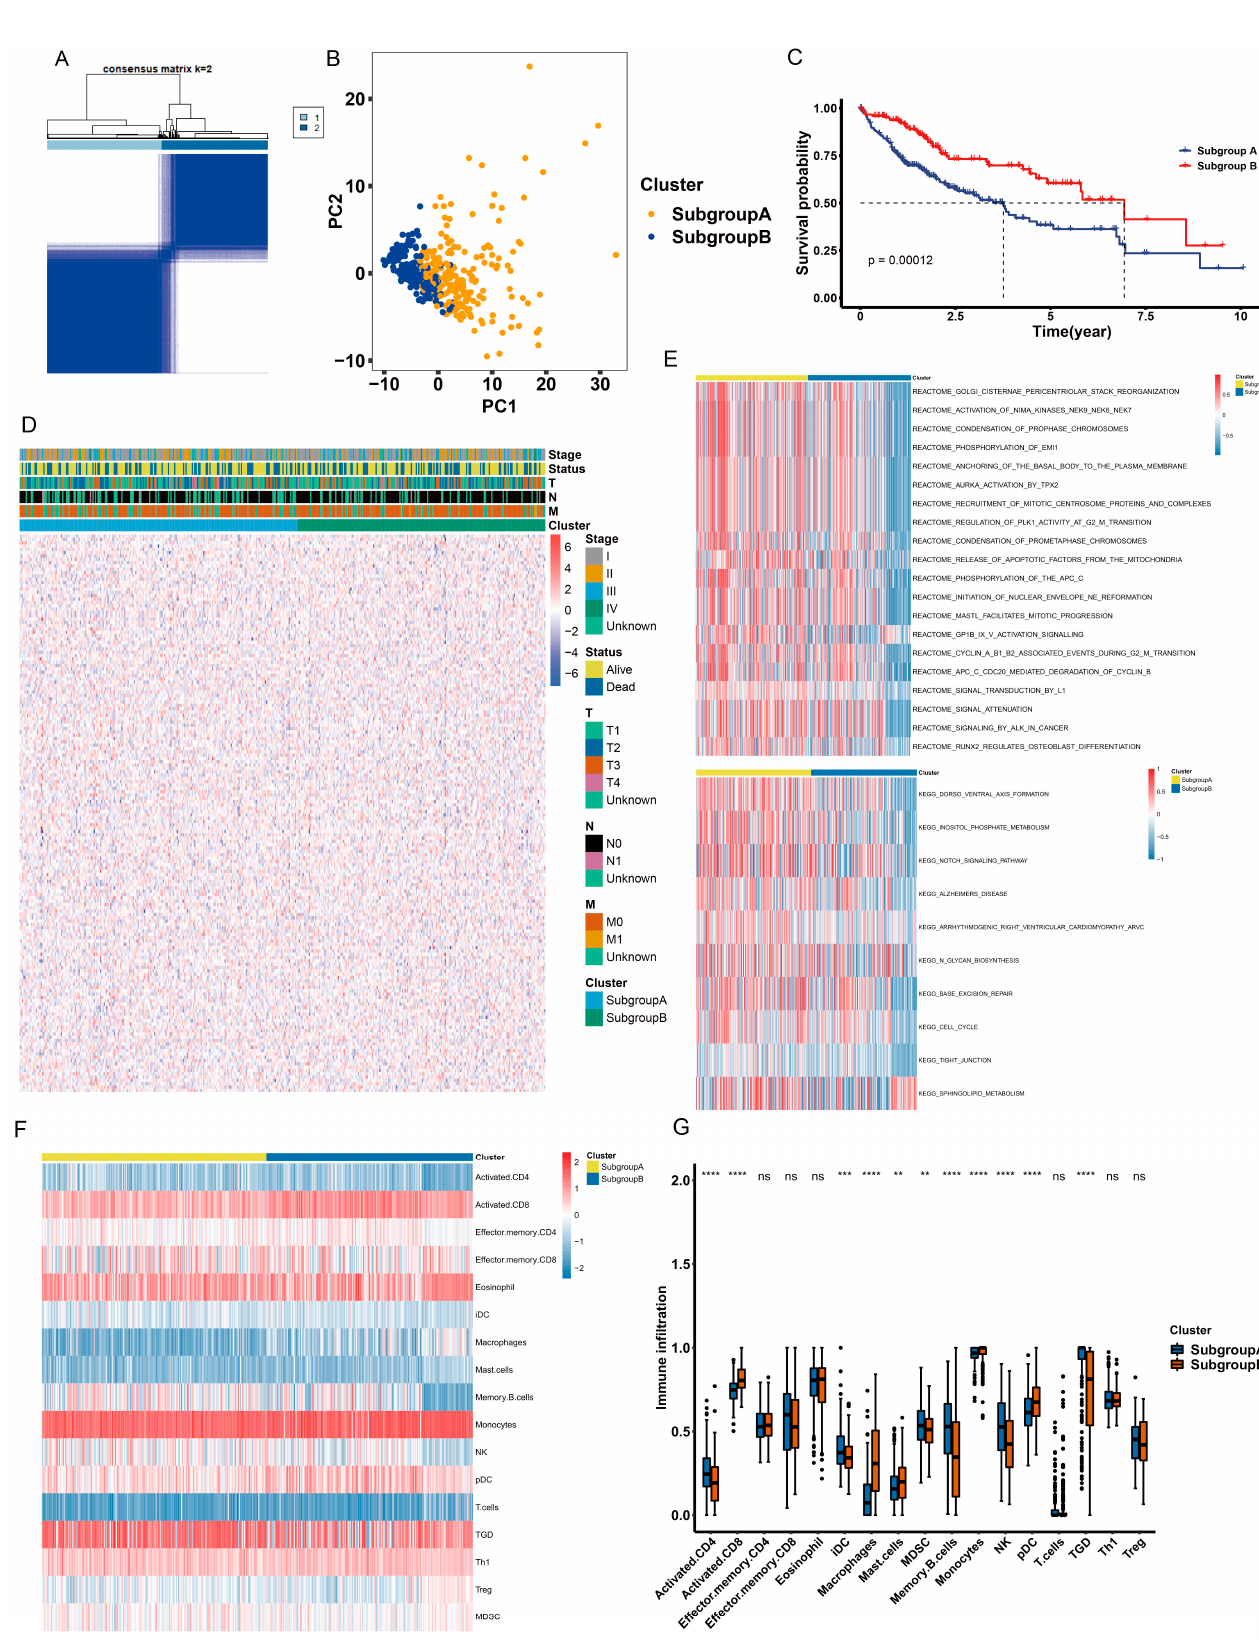
Figure 2. Identification of anoikis-related subgroups. ( A ) Consensus matrix heatmap defining two subgroups. TCGA-LIHC cohorts were divided into two subgroups based on gene expression profiles. The variable k is a parameter used to determine the number of clusters and k = 2 indicates that